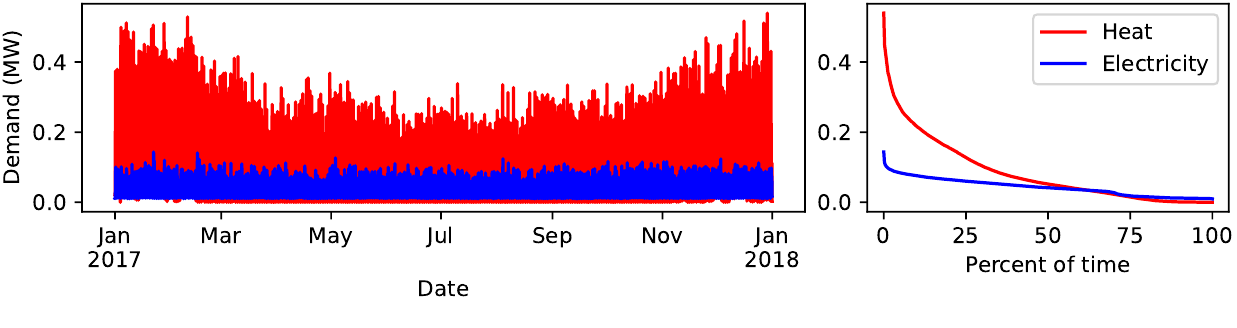
( b ) Energy demands (Flows 2 and 3 in (Flow 1 in Figure 3) Figure 4. Energy system input data; left: values over time, right: duration